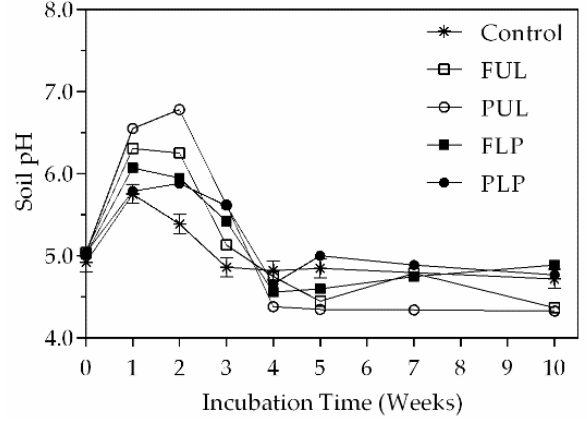
Figure 2. Evolution of soil pH during the soil incubation study.